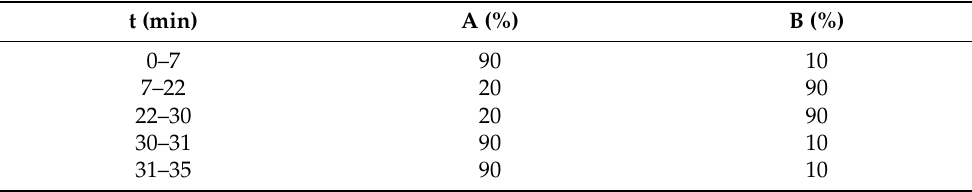
Table 3. Elution gradients for HPLC purification of compounds 1–18